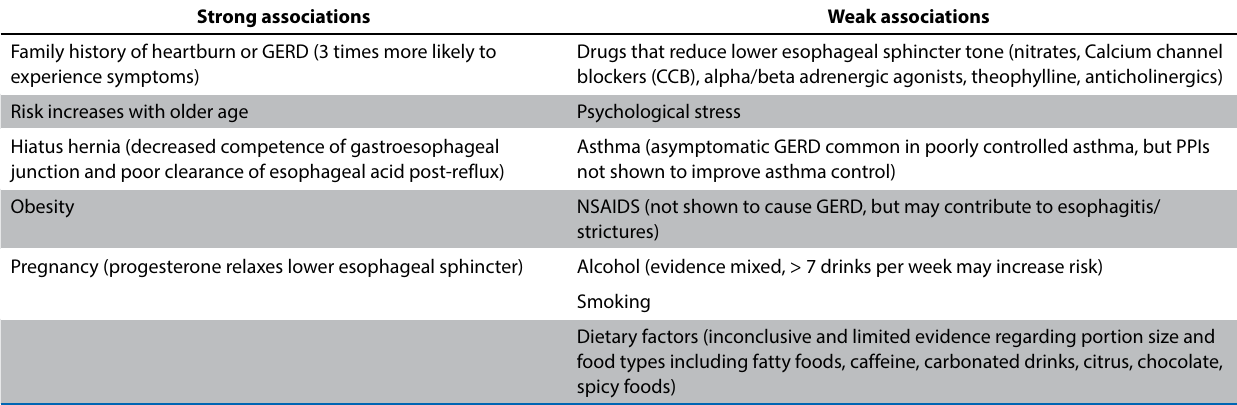
Table 1: Risk factors associated with GERD 39 Strong associations Weak